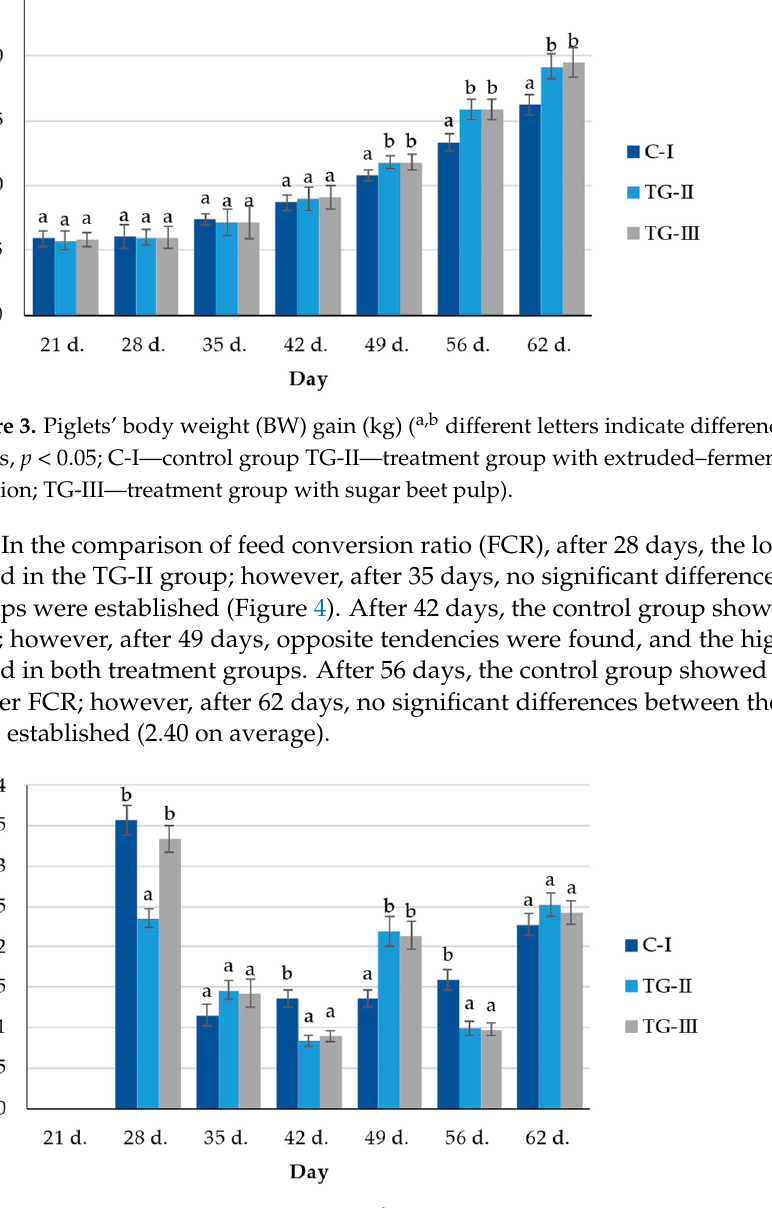
Figure 4. The feed conversion ratio (FCR) ( a,b different letters indicate differences among treatments, p < 0.05; C-I—control group TG-II—treatment group with extruded–fermented wheat bran addition; TG-III—treatment group with sugar beet pulp).